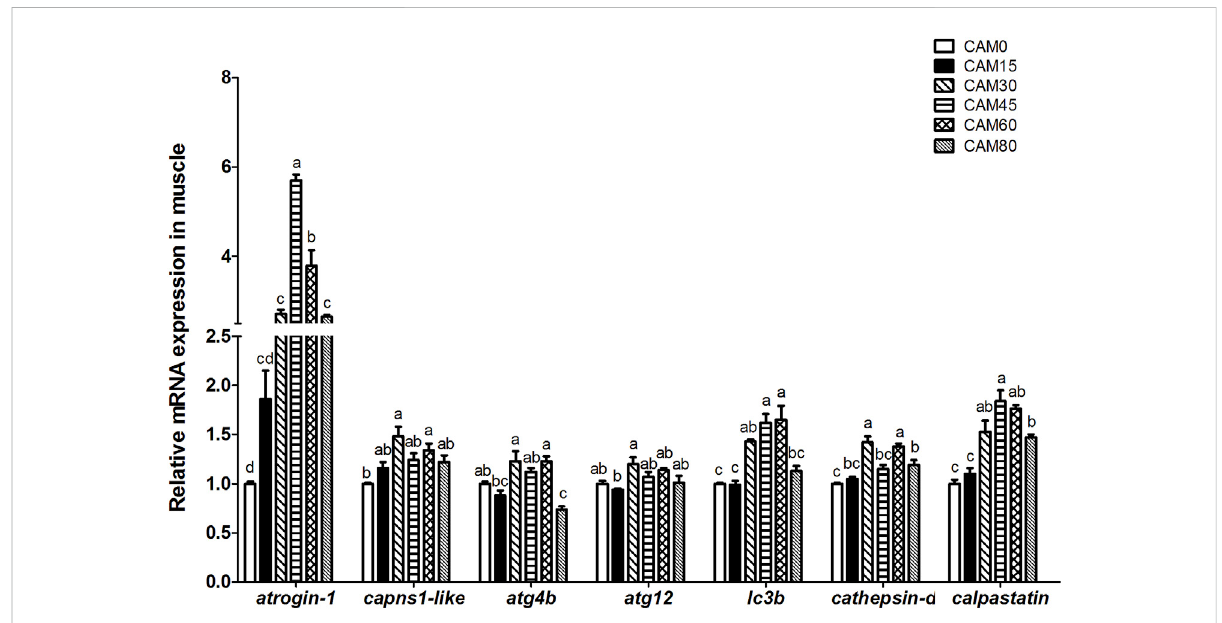
FIGURE 4 Relative mRNA expression related to protein degradation in muscle of juvenile turbot fed different diets. Data are presented as means ± S.E.M ( n = 3). Columns sharing the same superscript letter or absence of superscripts are not signi fi cantly different determined by Tukey ’ s test ( p > 0.05). Transcriptional levels were normalized by the reference gene of RNA polymerase II subunit D ( rpsd ). capns1-like, calpain small subunit 1-like; atg4b , autophagy related 4B cysteine peptidase. atg12 , autophagy related 12 homolog. Polynomial analysis: atrogin-1 : P value = 0.000, P Linear = 0.127, P Quadratic = 0.000; capns1-like : P value = 0.004, P Linear = 0.003, P Quadratic = 0.029; atg4b : P value = 0.000, P Linear = 0.936, P Quadratic = 0.013; atg12 : P value = 0.008, P Linear = 0.140, P Quadratic = 0.749; lc3b : P value = 0.000, P Linear = 0.004, P Quadratic = 0.000; cathepsin-d : P value = 0.001, P Linear = 0.000,